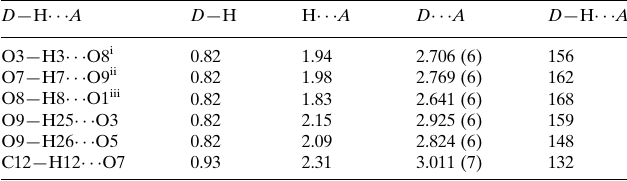
Hydrogen-bond geometry (A˚ , (cid:3)